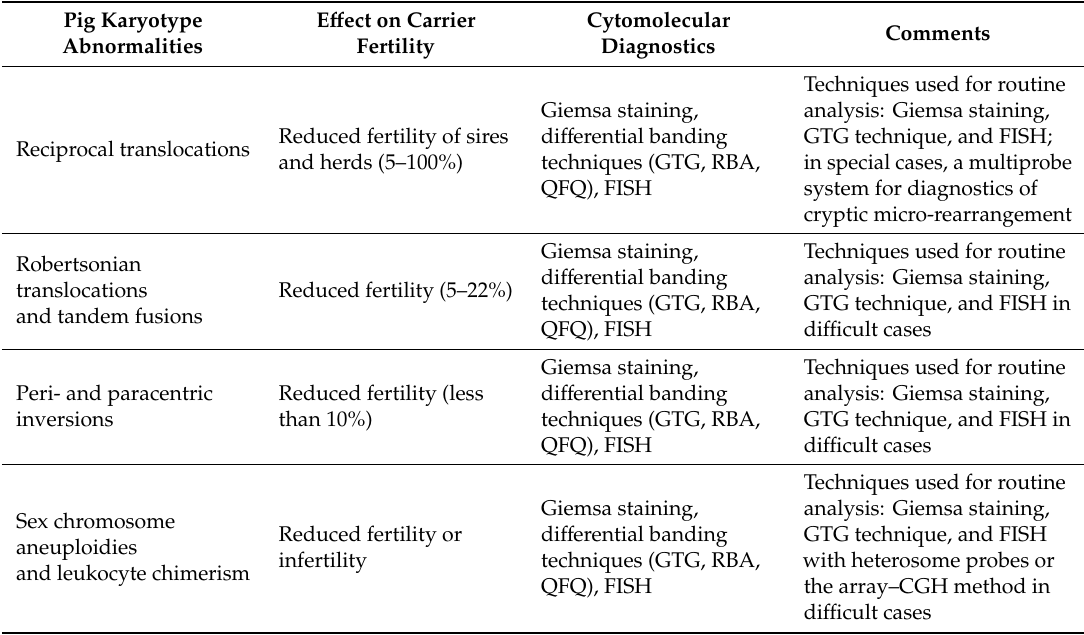
Table 1. Cytomolecular diagnostics methods and the types of karyotype